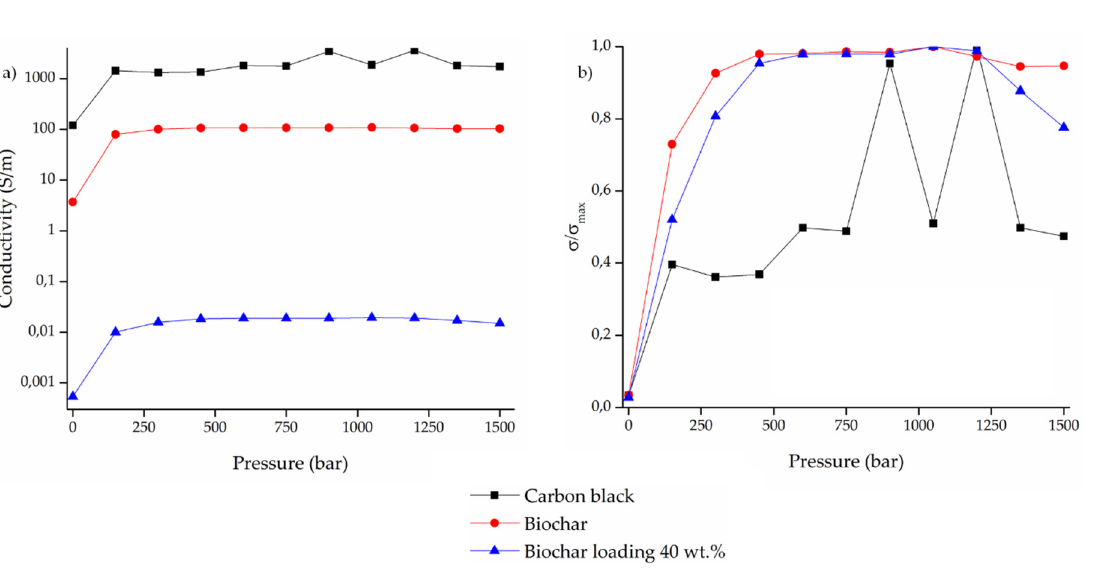
Figure 6. ( a ) Electrical conductivity measurement as a function of pressure on fillers and related composites containing biochar with a loading of 40 wt%, carbon black and tea biochar; ( b ) Electrical conductivity normalized on the highest value measured across the pressure range investigated.